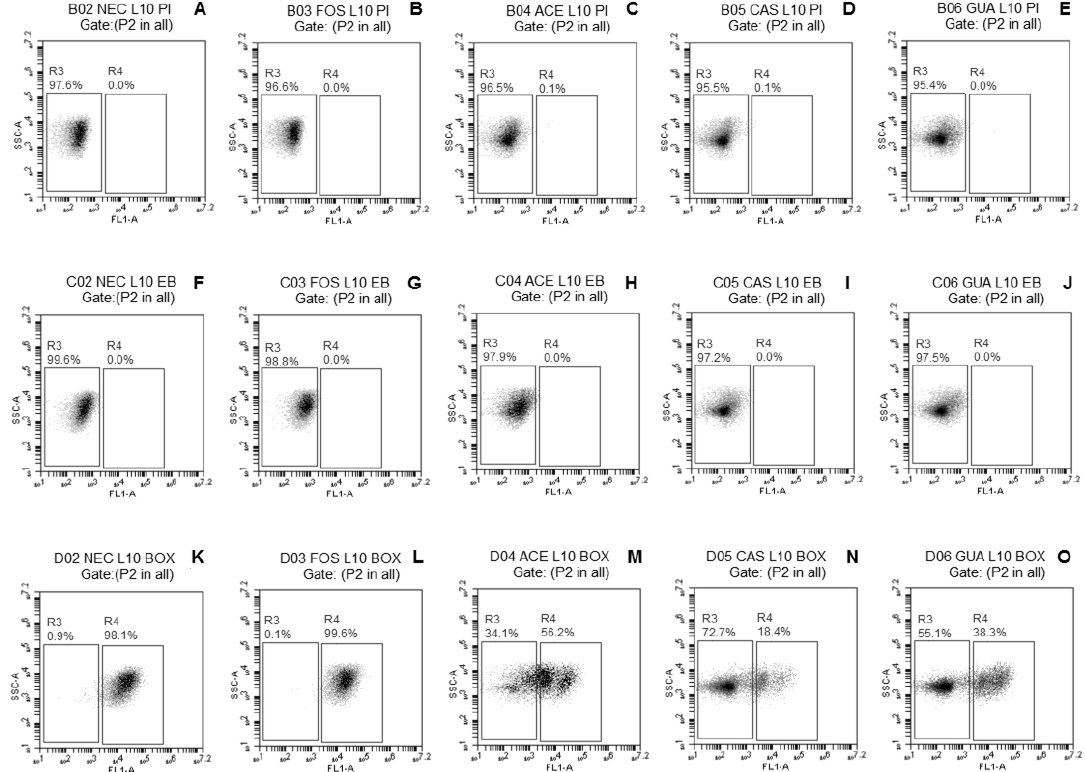
Figure 1. Fluorescence density plots of L. paracasei L-10 in response to staining with propidium iodide (PI) ( A – E ), ethidium bromide (EB) ( F – J ), and biz-1,3-dibutylbarbaturic acid [DiBAC 4 (3)] ( K – O ) after freeze-drying in the absence (NEC, ● ) or presence of fructo-oligosaccharides (FOS, ■ ) or processing coproducts of acerola (ACE, □), cashew (CAS , ▵ ), or guava (GUA, ○ ). L10 — L. paracasei L-10. The vertical axis indicates the fluorescence intensity of PI, EB, and DiBAC 4 (3) and the intensity of lateral light dispersal. The subpopulation of negative stains was blocked in the left rectangles; the positive subpopulation of the stains was delimited in the right rectangles. The percentages of cell subpopulations that fell on each port are shown in each plot.